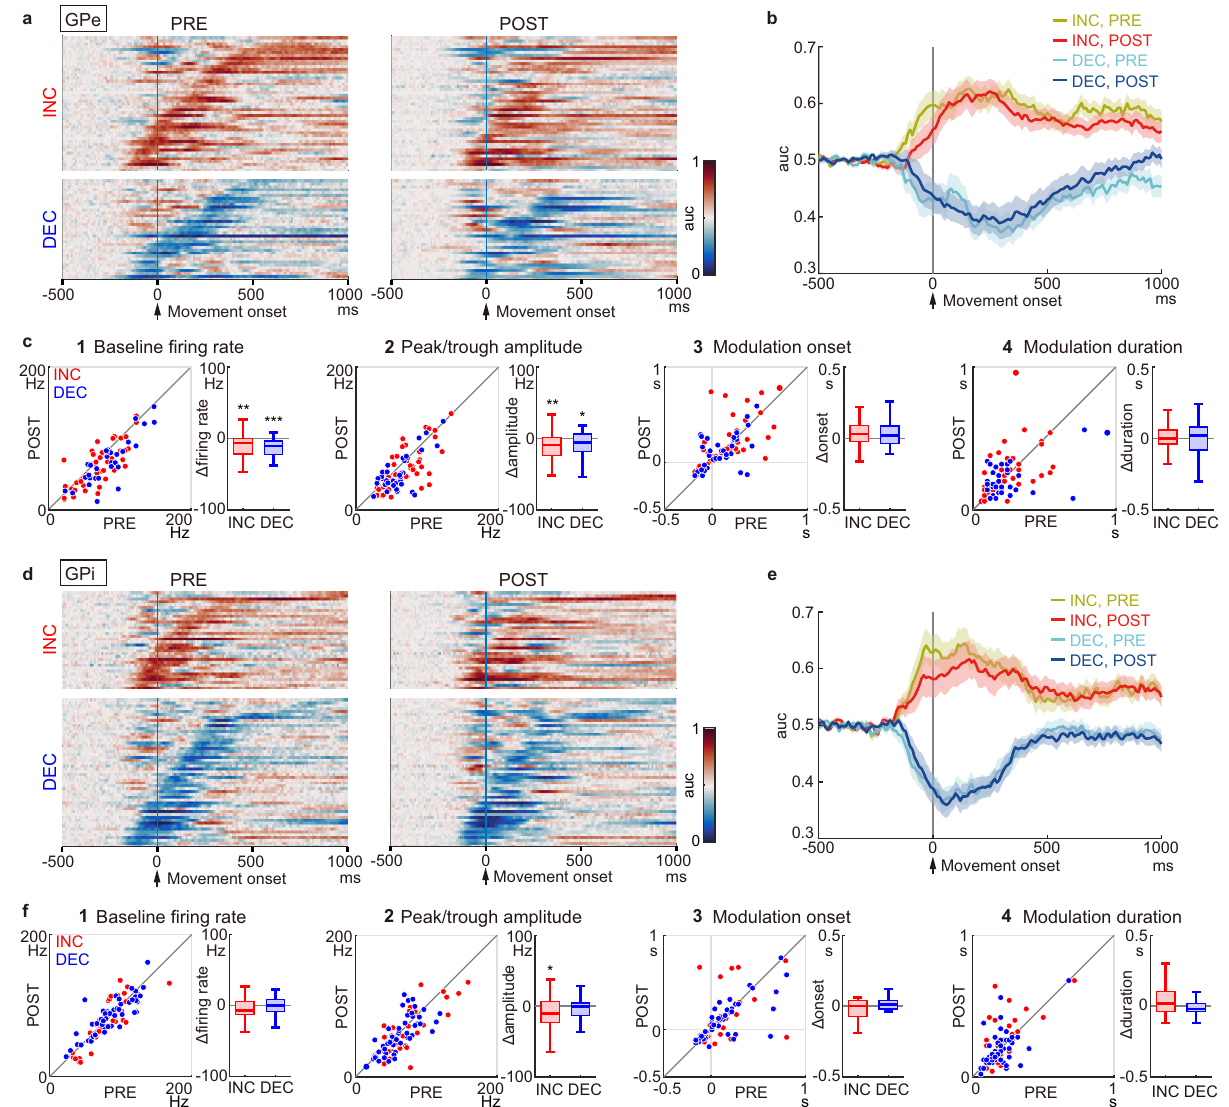
Fig. 3 Changes in movement-related activity of GPe/GPi neurons after reduction of STN activity in ET trials. a Heatmaps aligned with Movement onset for 78 GPe neurons classi fi ed as 43 INC- and 35 DEC-type neurons from monkeys K and U. Firing rates were converted to area under curve (auc) of ROC analysis. Neurons are sorted by the onset of movement-related activity in the PRE period (left). The activity of the same neuron in the POST period is shown on the same row (right). Bin width, 10 ms. b Population-averaged PETHs of INC- and DEC-type GPe neurons in the PRE and POST periods. c Scatter and box plots of change in PETHs between the PRE and POST periods of 43 INC- and 35 DEC-type neurons. c1 Baseline fi ring rate during the 500 ms preceding Task cue decreased (INC, P = 0.002; DEC, P = 1 × 10 − 5 ; two-tailed Wilcoxon-signed rank test); c2 Peak (INC) or trough (DEC) amplitude of the PETHs decreased (INC, P = 0.004; DEC, P = 0.02); c3 Onset of movement-related modulations; c4 Duration of movement-related modulations. * P < 0.05, amplitude of the PETHs decreased ( P = 0.02). Solid lines and shading indicate mean and SEM, respectively ( b , e ). In box plots, an inner horizonal line represents median; box, 25th and 75th percentiles; whiskers, maximum and minimum values within 1.5 times the interquartile range from the upper and lower quartiles ( c , f